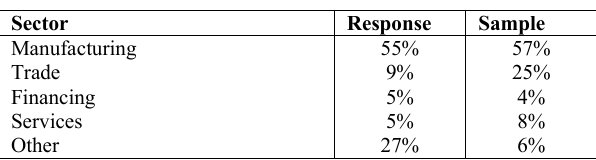
Table 1: Sectoral breakdown of respondents compared to sample